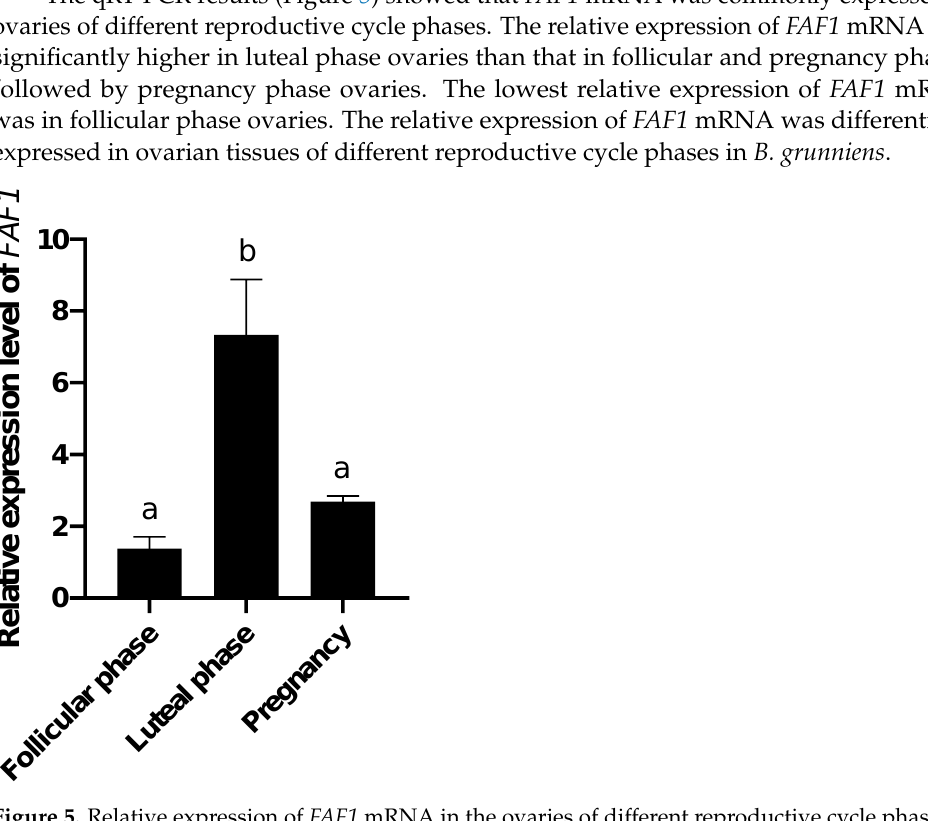
Figure 4. Localization of FAF1 protein expression in testes of different ages. (A – L) Immunohisto-